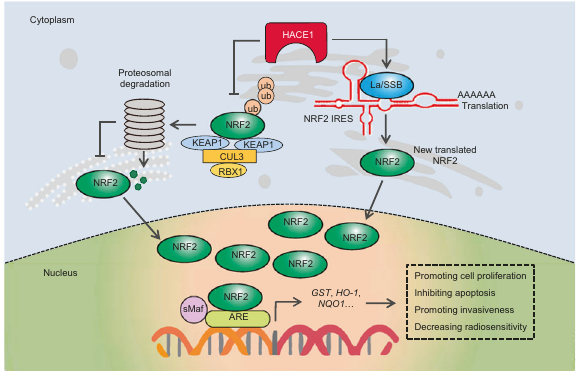
Fig. 8 A schematic model for HACE1 promoting malignant phenotypes and reducing radiosensitivity of glioma cells. Brie fl y, increased expression of HACE1 enhances protein stability of NRF2 through competitively binding to NRF2 with another E3 ligase KEAP1. On the other hand, HACE1 promotes IRES-mediated mRNA translation of NRF2. HACE1 thus contributes to malignant behaviors and decreased radiosensitivity of glioma cells by activating